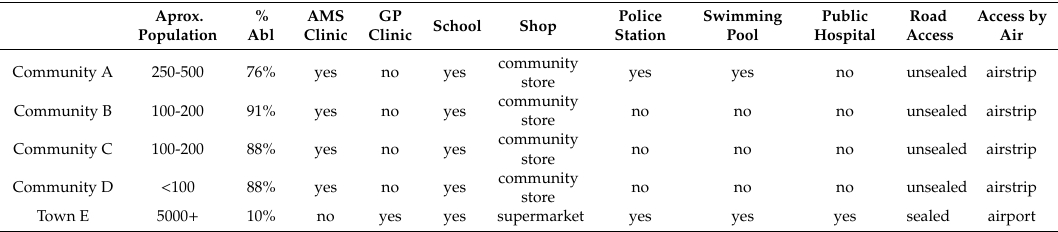
Table 1. Description of study area